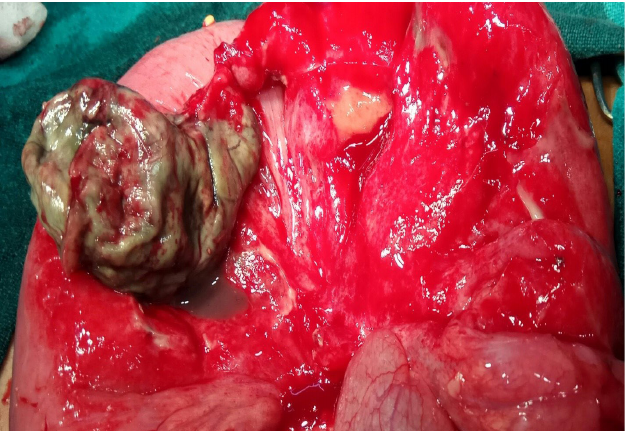
Fig. 2. Axial twisting of dive rticulum with a fibrous band attached to the fundus and ileum leading to gangrenous diverticulum.